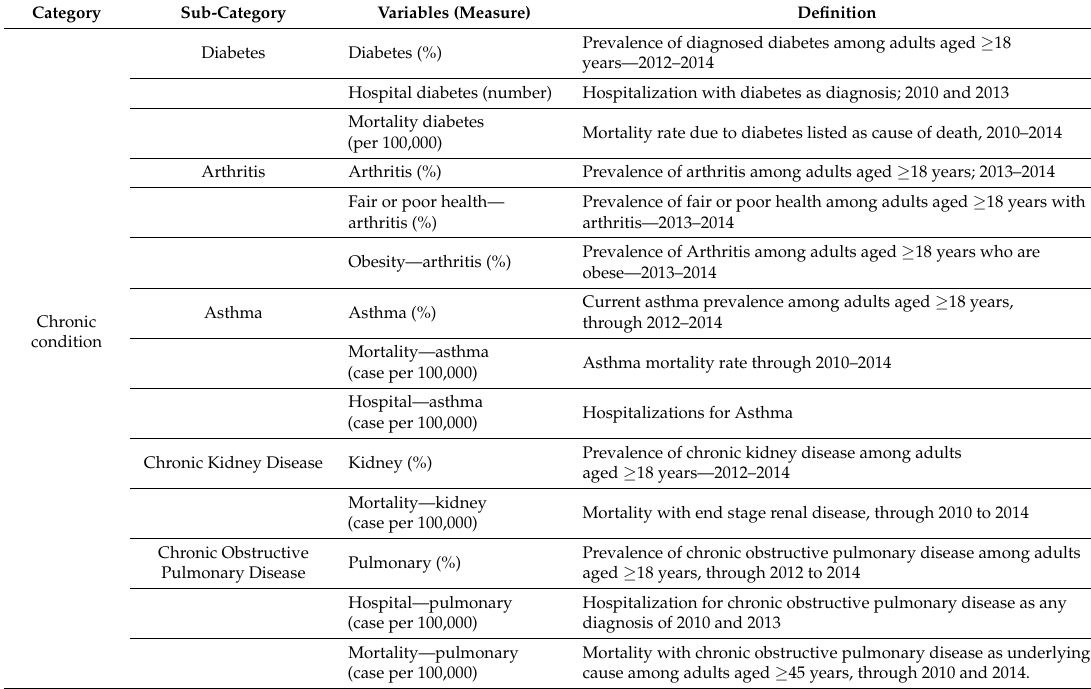
Table 1. Chronic diseases and related